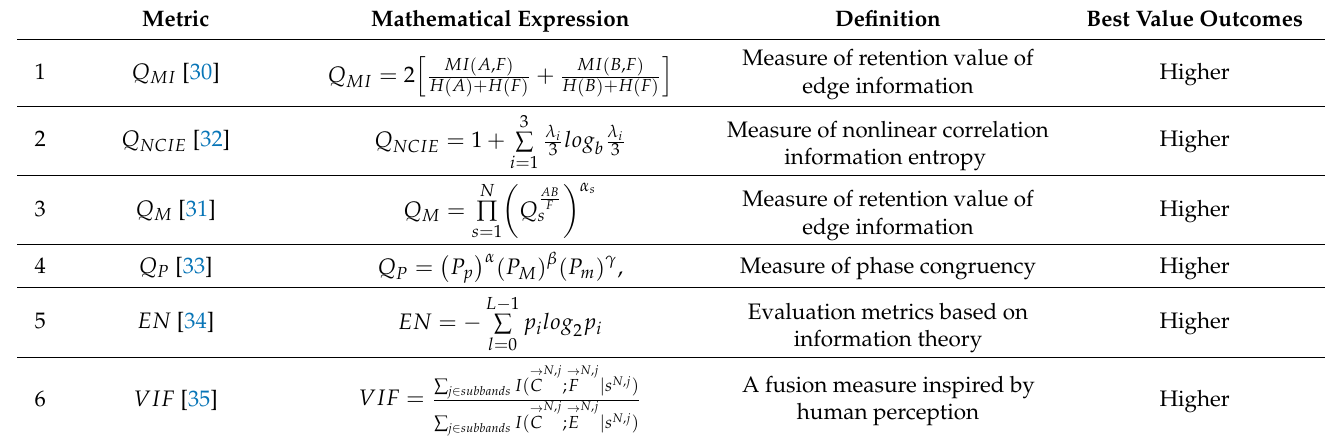
Table 1. Quantitative evaluation metrics used in the